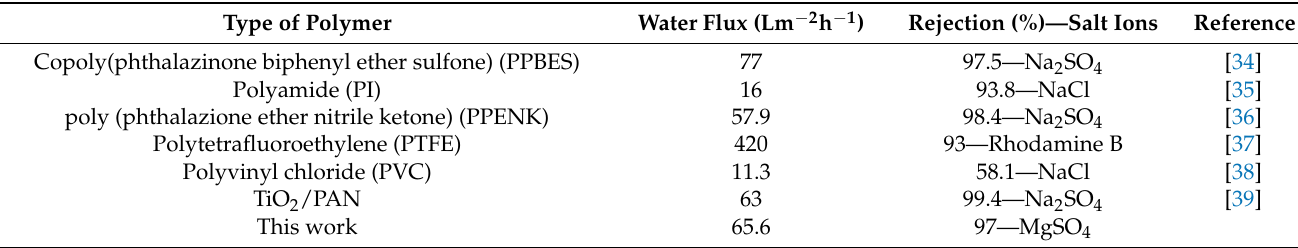
Table 5. Comparison performance of fabricated TFC membrane with literature